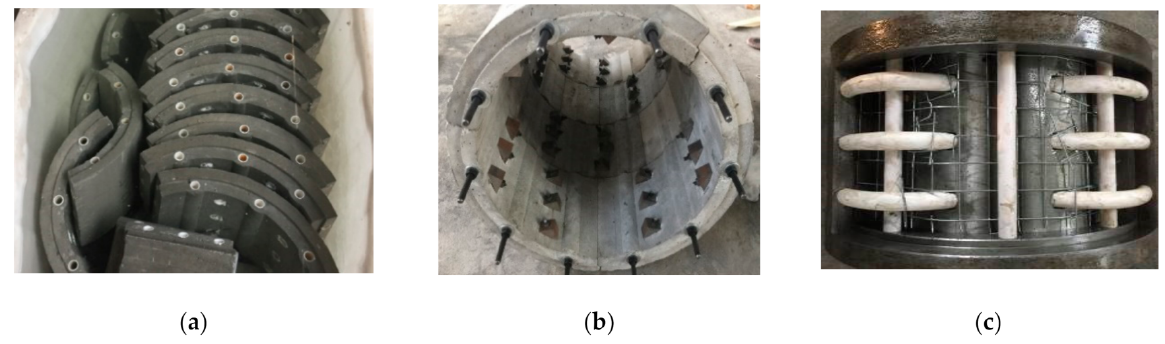
Figure 2. The LCSS and mold. ( a ) Segments; ( b ) Sleeve; ( c ) Mold of